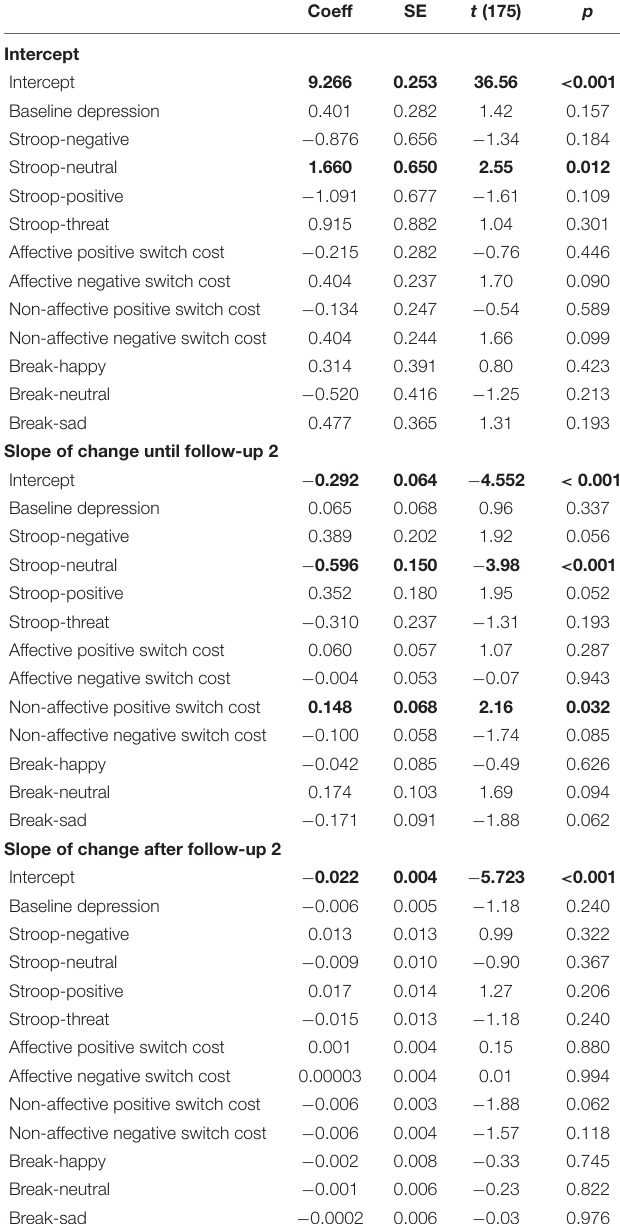
TABLE 4 | Predicting the level and trajectory of